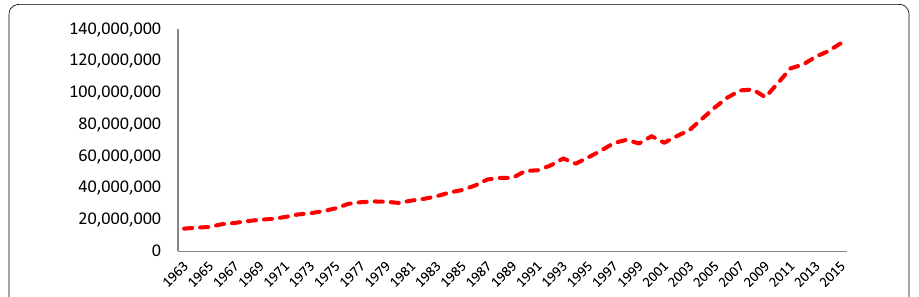
Fig. 4 Real GDP (annual, 1963–2015) Source : Real GDP data were derived from the Ministry of Development’s report (Economic and Social Indicators between 1923 and 2014), the year of 2015 for Turkey was derived from UN data (LCU)